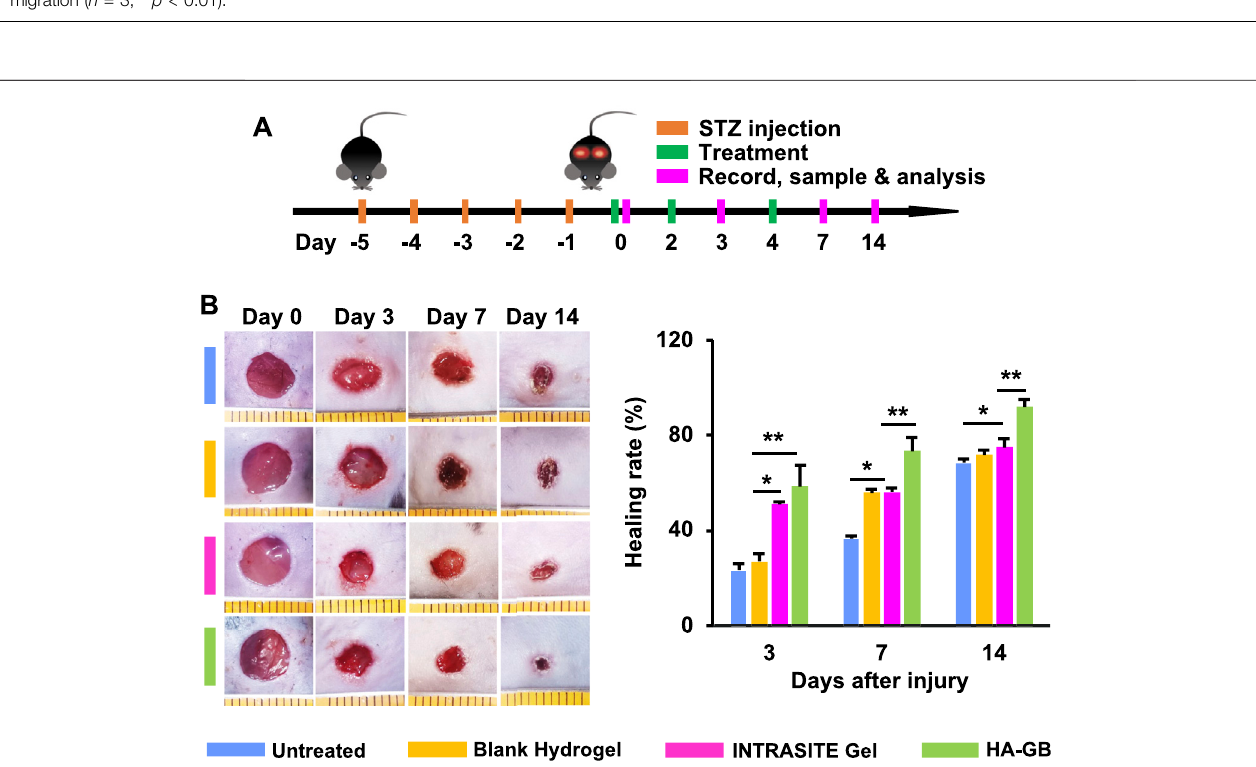
FIGURE 4 | HA-GB facilitates in vivo diabeticwound healing. (A) Treatment, sample and analysis schematic. (B) The wound images following treatment of HA-GB (1,000 μ mol/L). Healing rate (%) ( n = 8; * p < 0.05 and ** p < 0.01).